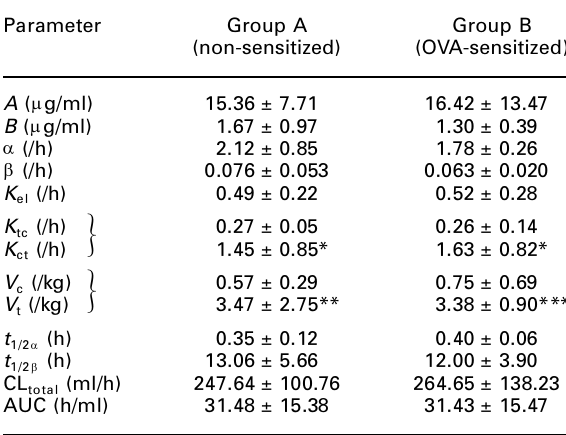
Table 1. Pharmacokinetic parameters for monoclonal DNP- specific rat IgE administered to non-sensitized and OVA- sensitized